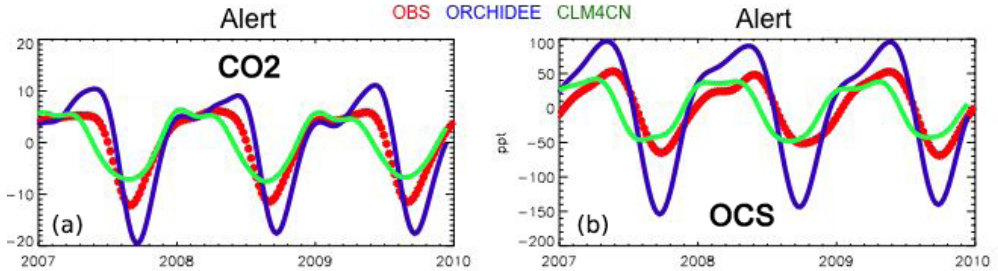
Figure 11. Smoothed seasonal cycles of OCS (right) and CO 2 (left) monthly mean mixing ratios, simulated at Alert station, Canada, obtained after removing the annual trends. Simulations are obtained with the LMDz transport model, using two flux scenarios for the vegetation uptake of OCS, calculated with the GPP of ORCHIDEE and CLM4CN models; the other OCS flux components are identical (see Launois et al. 2015). Observations (red) are from the NOAA/ESRL global monitoring network (Montzka et al., 2007) averaged from 2007 to 2010.